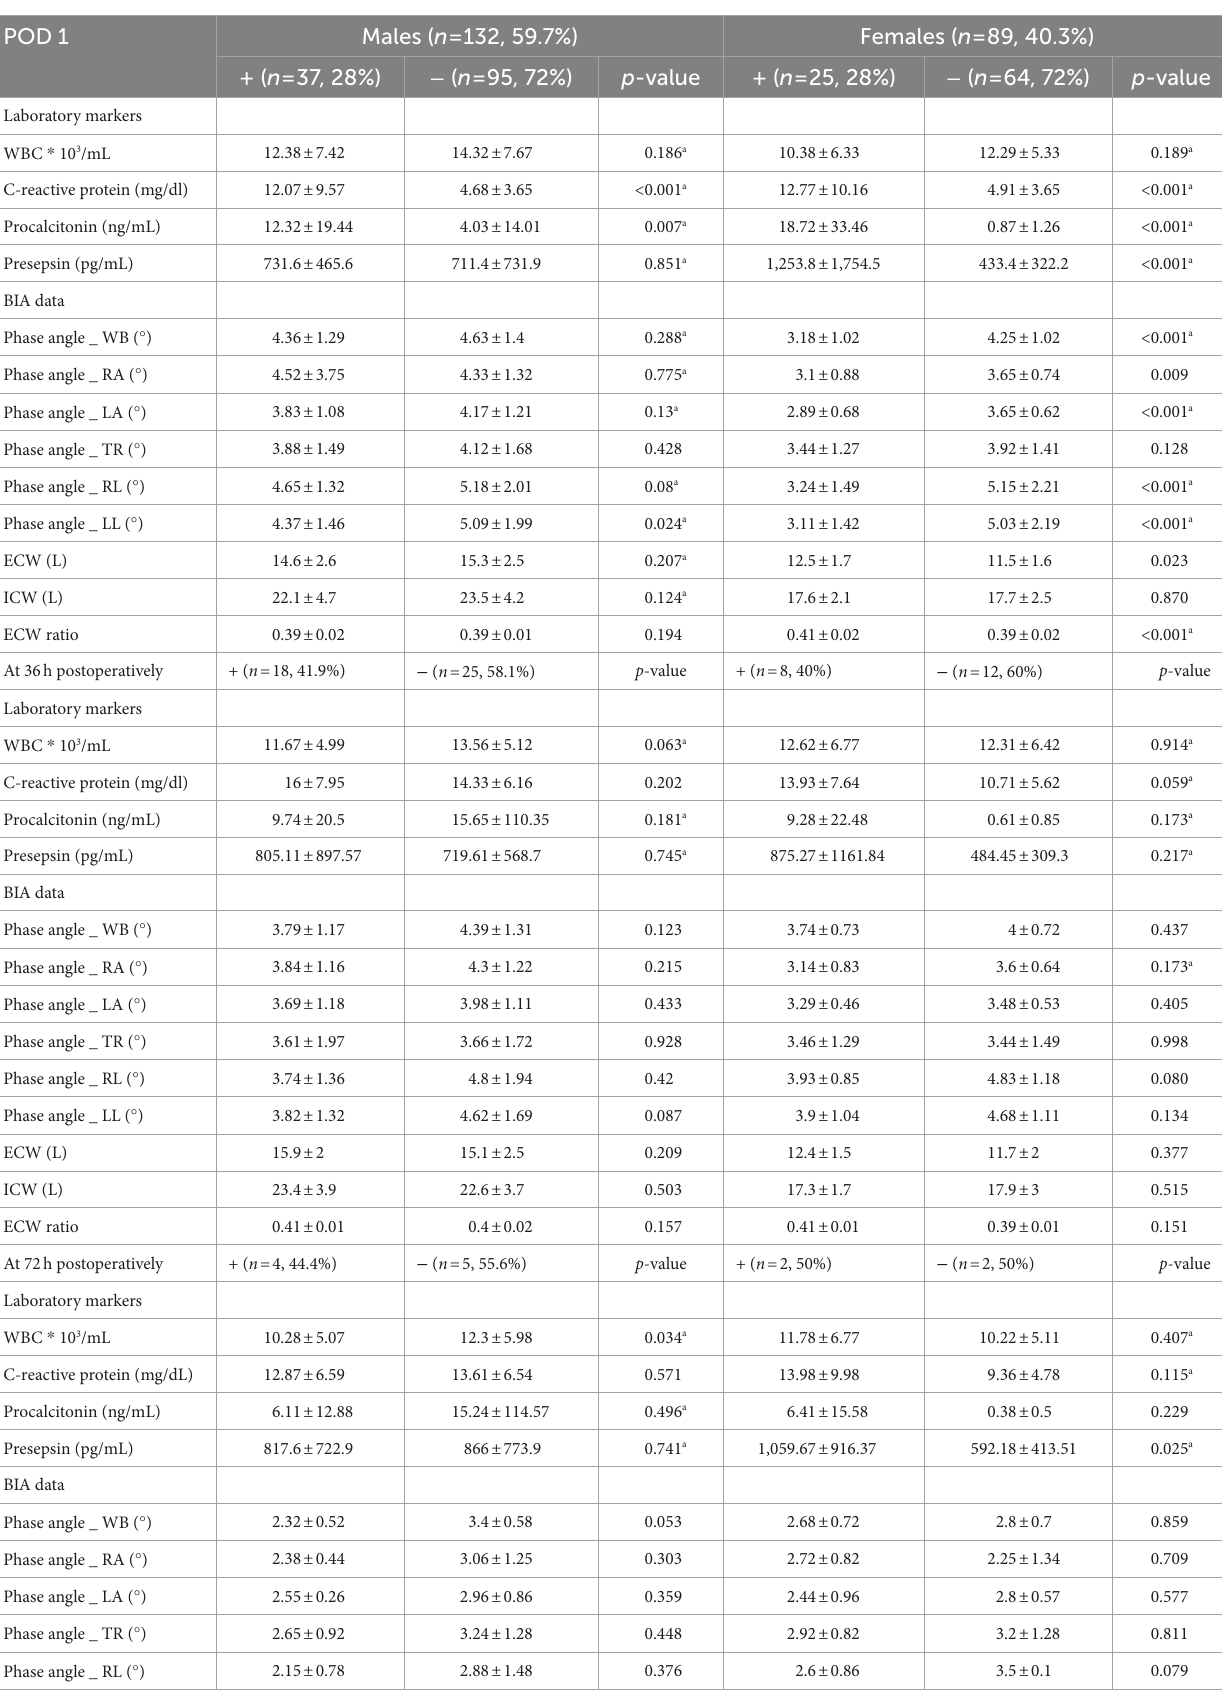
TABLE 5 Comparative analysis of laboratory markers and BIA data between two groups according to occurrence the infection after surgery by dividing into males and females. POD 1 Males ( n = 132,